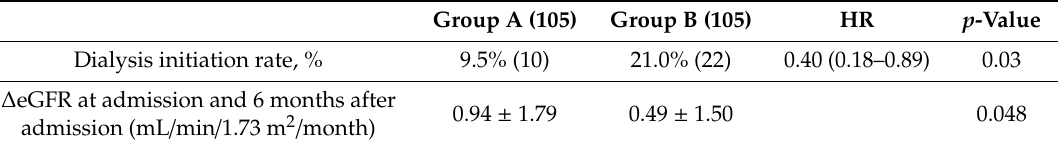
Figure 3. Dialysis induction rate within one year after admission. The p -values were statistically analyzed by chi-square test. analyzed by chi-square test. Table 3. Comparison between groups after propensity score